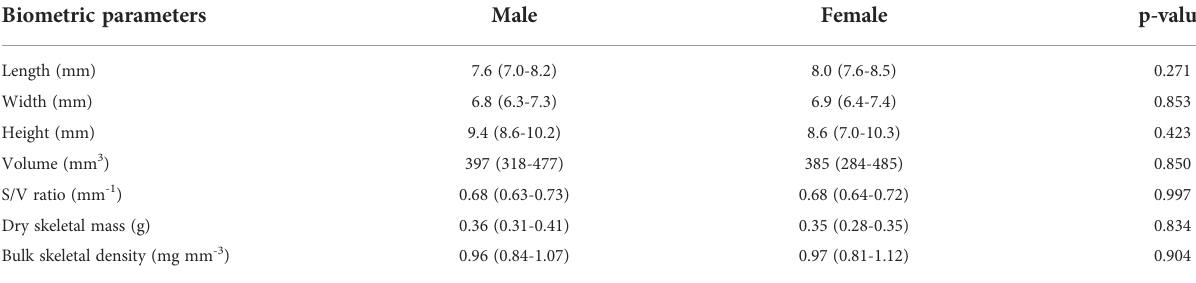
TABLE 2 Mean biometric parameters, 95% con fi dence intervals (CI) and t-test p-value of sexually active polyps (males and females). Biometric